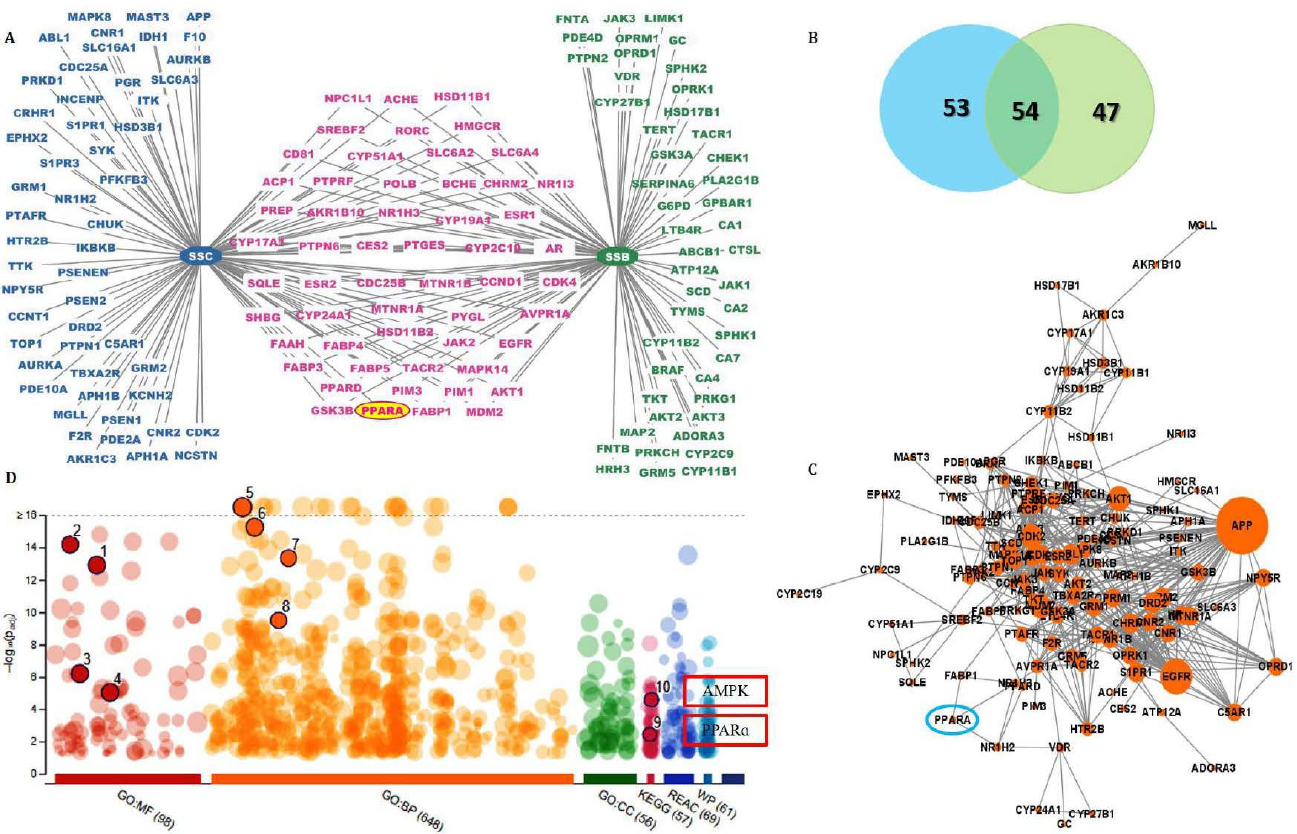
Figure 2. The network pharmacological analysis between soyasapogenol B and soyasapogenol C. ( A ) Target network prediction of SSB and SSC; ( B ) the Venn diagram of the targets of SSB–SSC; ( C ) Protein–protein interactions of the overlapped targets between SSB and SSC; ( D ) The enriched KEGG pathways of the overlapped targets between SSB ‐ SSC using g: Profiler. Numbering represents 1—Kinase activity; 2—Protein kinase activity; 3—Lipid binding; 4—Kinase binding; 5—Lipid metabolic process; 6—Lipid biosynthetic process; 7—Regulation of lipid metabolic process; 8—Lipid catabolic process; 9—PPAR α signaling pathway; 10—AMPK signaling pathway.